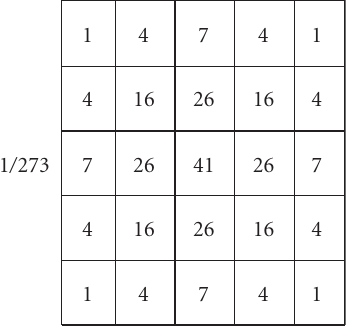
Figure 2.2. The discrete approximation of the Gaussian kernel shown in Figure